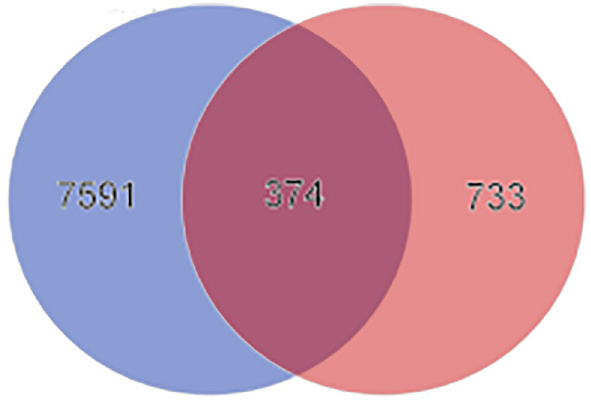
Figure 2. Venn diagram of 374 targets of WFEA and lung adenocarcinoma.